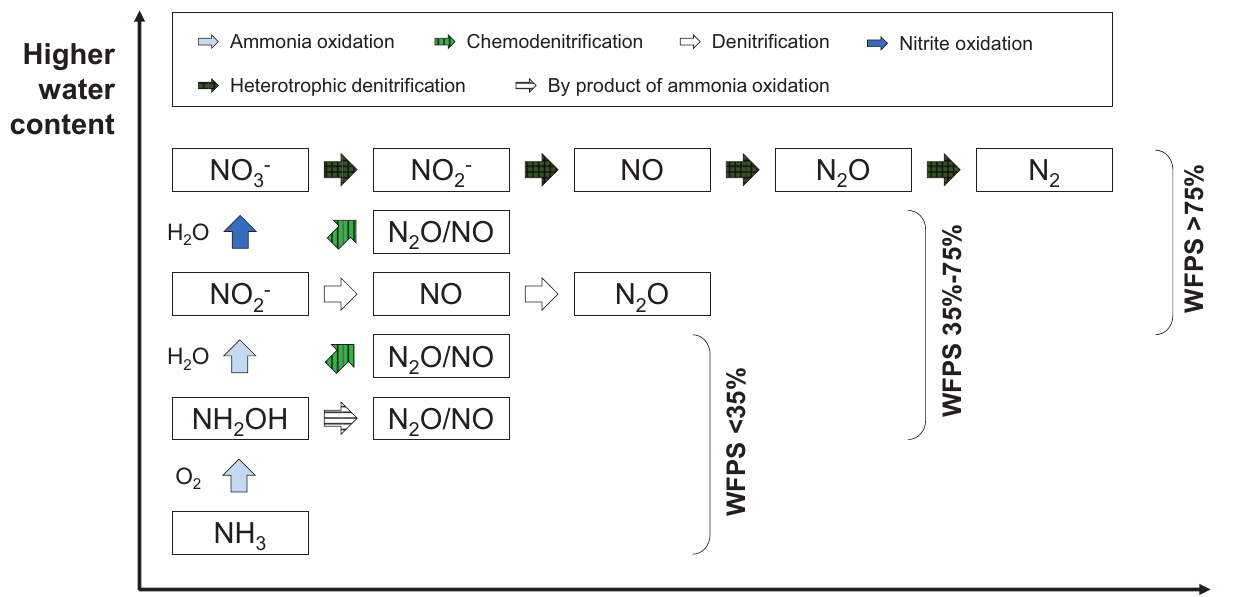
is limited by water stress. Yang et al. (2009) indicated that an ideal L-P content was obtained at 50% of field capacity, as it was suitable for substrate phosphatase to enhance activity, and thus promoted the release of L-P from